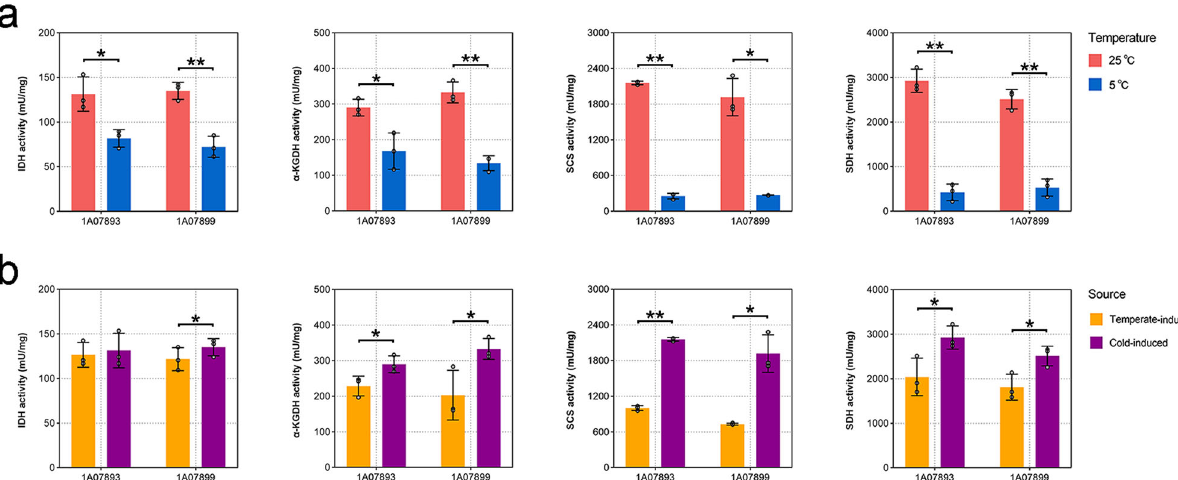
Fig. 5 Activities of the TCA cycle enzymes. a Activities of low-temperature-induced enzymes extracted from cultures at 5 °C and measured at 5 and 25 °C. b Activities of cold-induced (derived from cultures at 5 °C) and temperate-induced (derived from cultures at 25 °C) enzymes measured at 25 °C. One unit of IDH was de fi ned as the amount of enzyme that generates 1.0 μ mole of NADPH per minute at pH 8.0 at 5 °C or 25 °C, one unit of α -KGDH was de fi ned as the amount of enzyme that generates 1.0 μ mole of NADH per minute at pH 7.5 at 5 °C or 25 °C, one unit of SCS was de fi ned as the amount of enzyme that generates 1.0 mmole of NADH per minute at pH 7.4 at 5 °C or 25 °C, and one unit of SDH was de fi ned as the amount of enzyme that generates 1.0 μ mole of DCIP per minute at pH 7.2 at 5 °C or 25 °C. The experiments were performed in triplicate and the average values are given. Error bars represent standard deviations. Signi fi cant differences between the two datasets are indicated by asterisks (* p < 0.05; ** p <